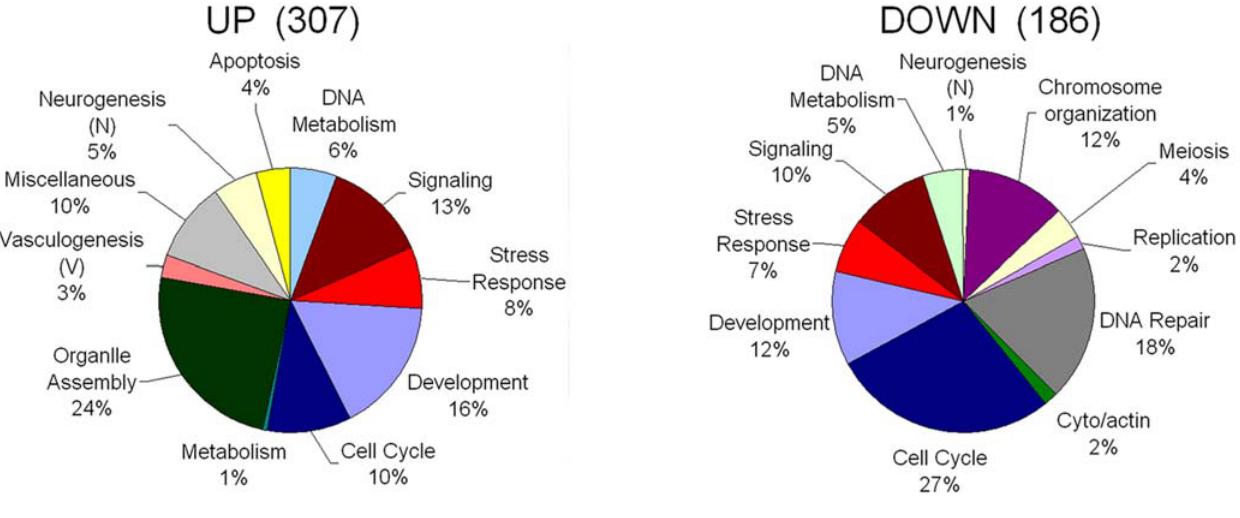
Figure 4. Distribution of biological functions associated with ESC genes identified as expressed during fracture repair. Two major temporal grouping of gene expression (Up or Down) is presented in a pie graph. Distribution of biological functions was based on analysis of the groupings of the temporal clusters as indicated in figure one using. Up and Variable groupings were consolidated together for analysis using Database for Annotation, Visualization and Integrated Discovery (DAVID). Only those biological functional ontologies with p , .05 were considered and those with over lapping functions were consolidated into single categories as indicated in Table S2. The total number of genes within each of the major groupings is indicated in the figure and percentage distributions of the grouping were calculated as descried in the materials and methods. A uniform color coding between the pie graphs for the biological groupings was used for comparisons between the groups.